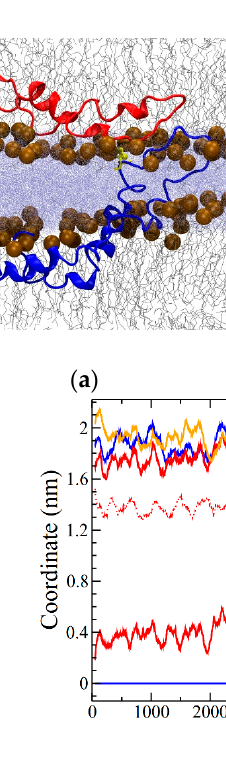
nm of lateral distance from the protein (red) are plotted, illustrating bilayer separation. All coordinates are in reference to the overall lower leaflet position. The dashed red line corresponds to the difference between the red lines. Green lines show the position of F1, solid for the red subunit and dashed for the blue, as an indicator of the position of the residue 1–7 insertion sequence. The data are running averages over 50 points.